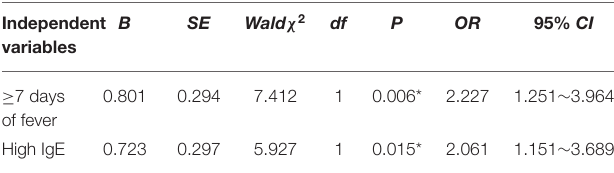
TABLE 3 | Multivariate logistic analysis of severe